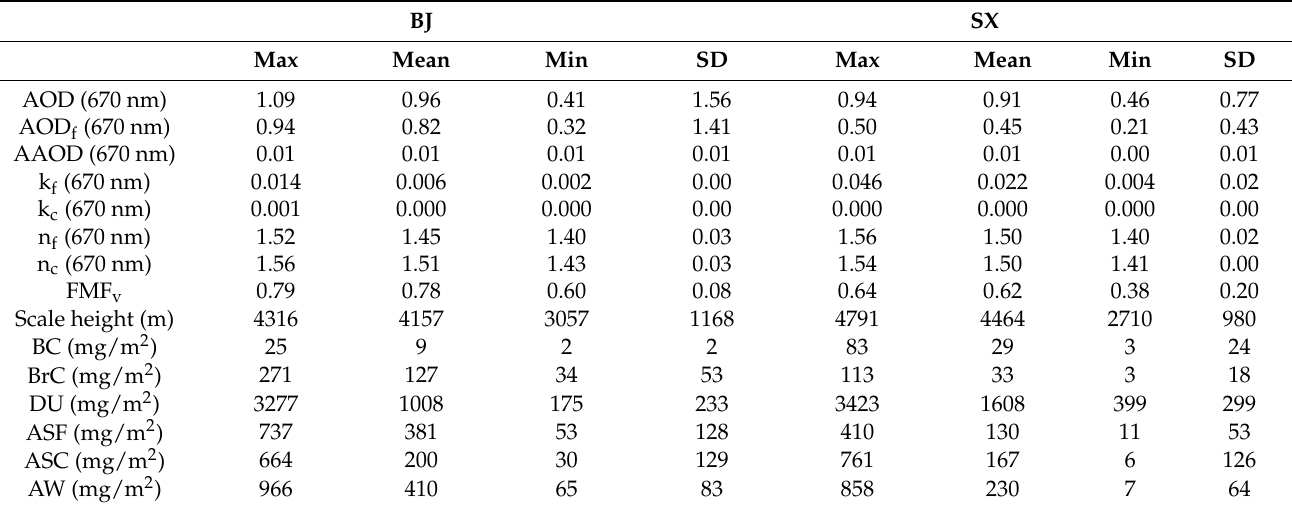
Table 2. Monthly mean aerosol optical microphysical properties and components of BJ and SX case study (BJ and SX regions in Figure 1). Max is the maximum, min is the minimum, SD is the standard error